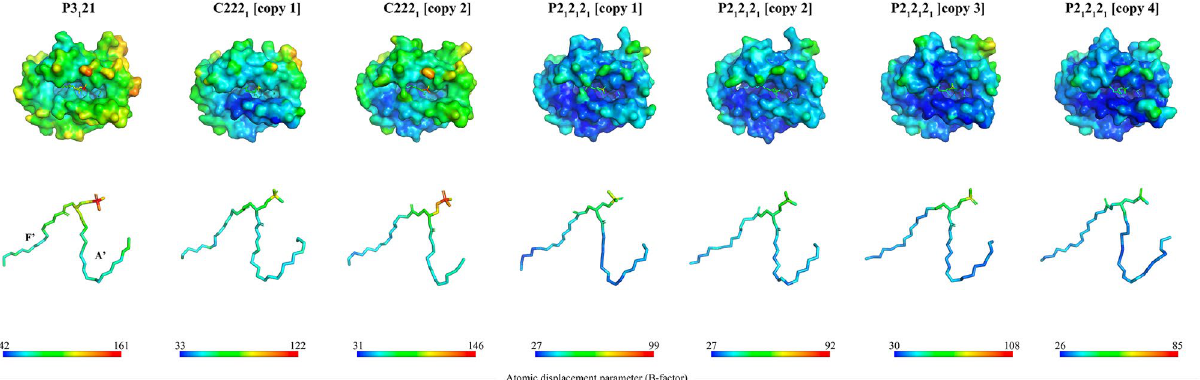
Figure 5. Mapping of the static disorder in the EPCR-lipid complexes. All EPCR molecules are shown in surface format, and colored according to their ADP (B-factor) value, which is a measure of the atomic disorder from a mean position. The B-factor scale is displayed as a colored scale bar showing the minimum and maximum values for each structure. To ease visualization of the B-factor gradient, the lipid molecule for each structure is extracted in the middle panel. All structural figures and scale bars were prepared with PyMOL version 2.5.2.